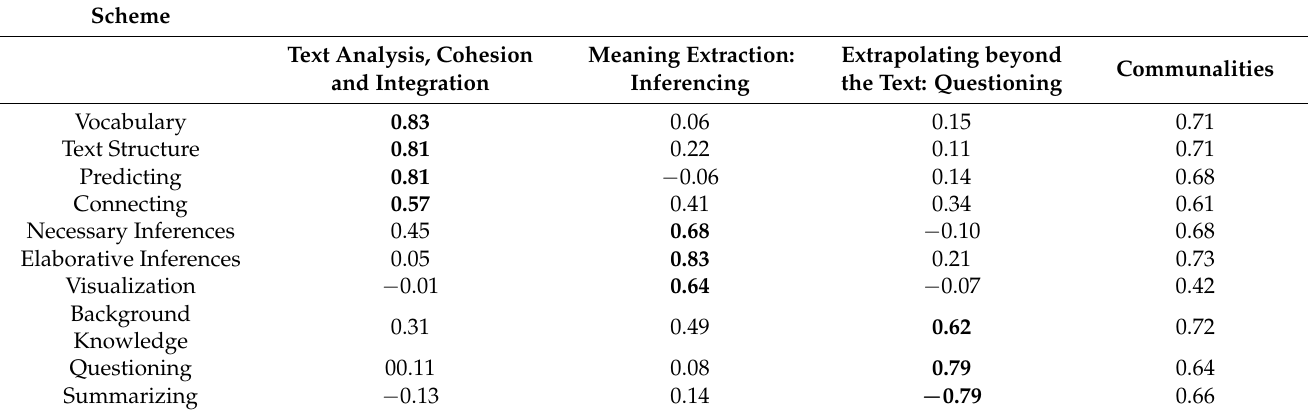
Table 7. Rotated Factor Loadings and Communalities for Each Strategy Used in French Think-Alouds.